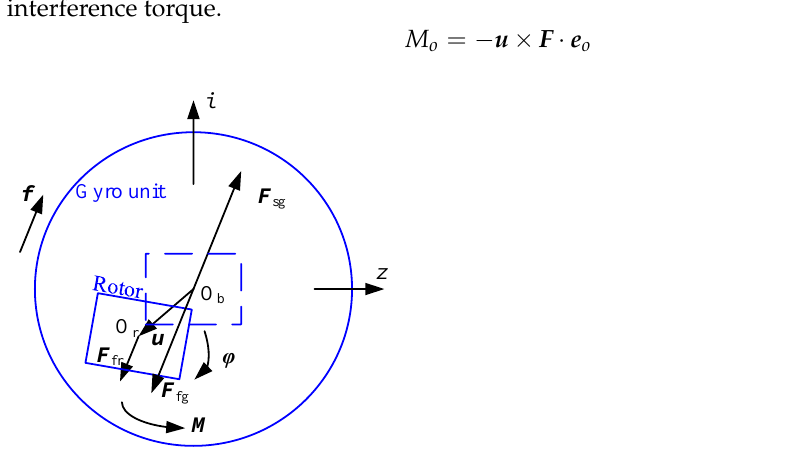
Figure 7. Schematic of the interference torque generation.